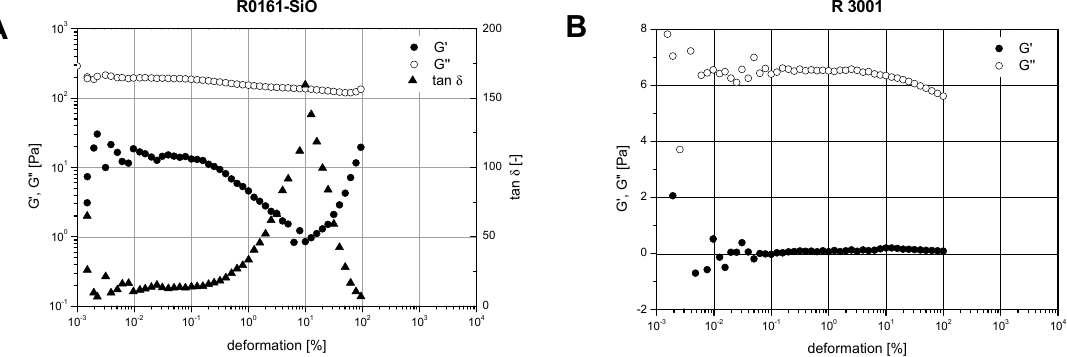
Figure 8. Strain sweep tests under oscillatory shear at 6 rad/s of material category Figure 8 . Strain sweep tests under oscillatory shear at 6 rad/s of material category II.